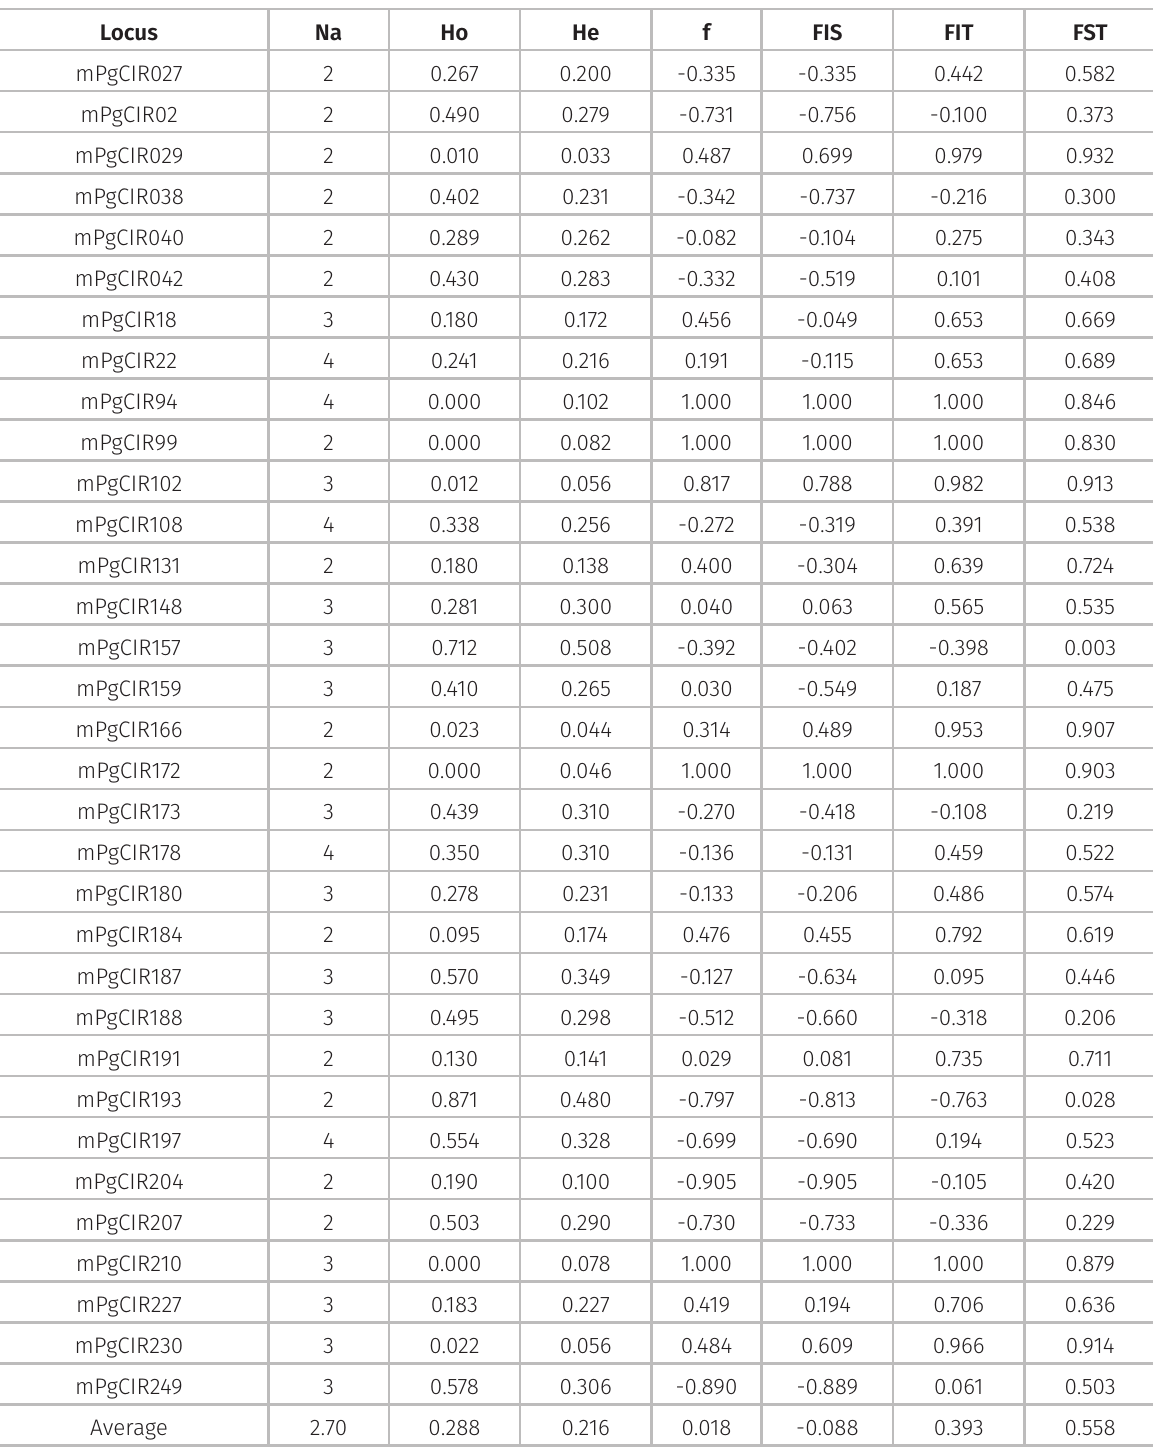
Table III. Number of alleles per locus (Na), observed heterozygosity (Ho), expected heterozygosity (He), fixation index (f), coefficient of inbreeding among individuals in the subpopulations (FIS), degree of genetic differentiation among the total populations (FIT), and degree of genetic differentiation among the subpopulations (FST) of microsatellite primers evaluated in 94 individuals originating from five populations obtained from interspecific crosses of Psidium